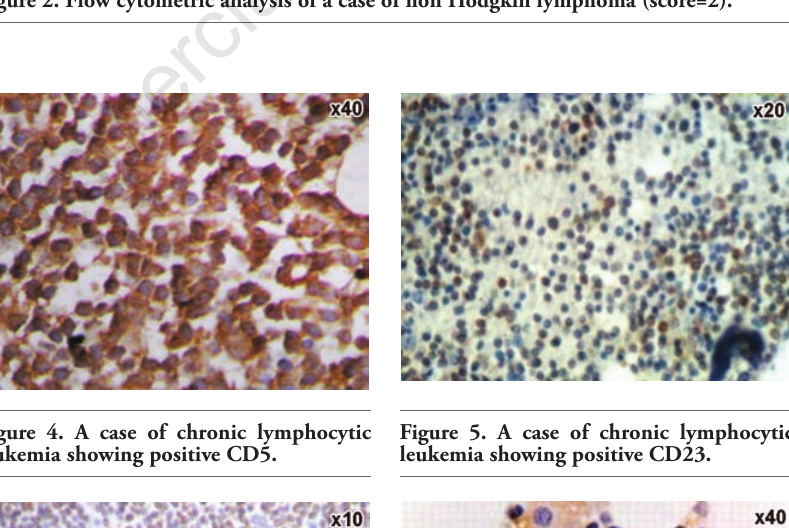
Figure 2. Flow cytometric analysis of a case of non Hodgkin lymphoma (score=2).